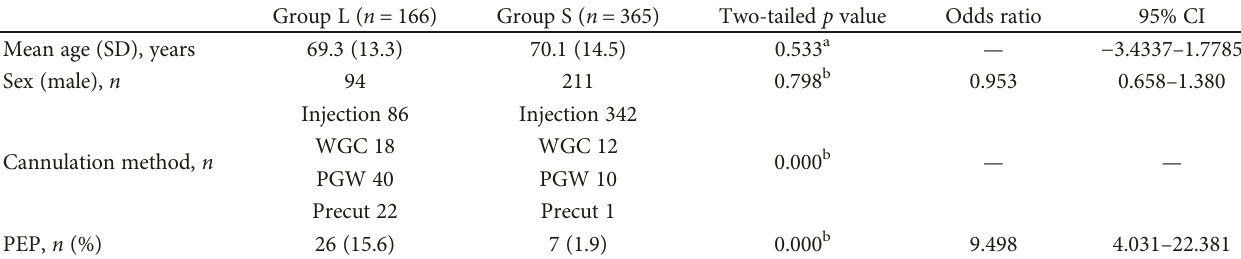
Table 1: Clinical characteristics of the patients, applied cannulation method, and PEP incidence.